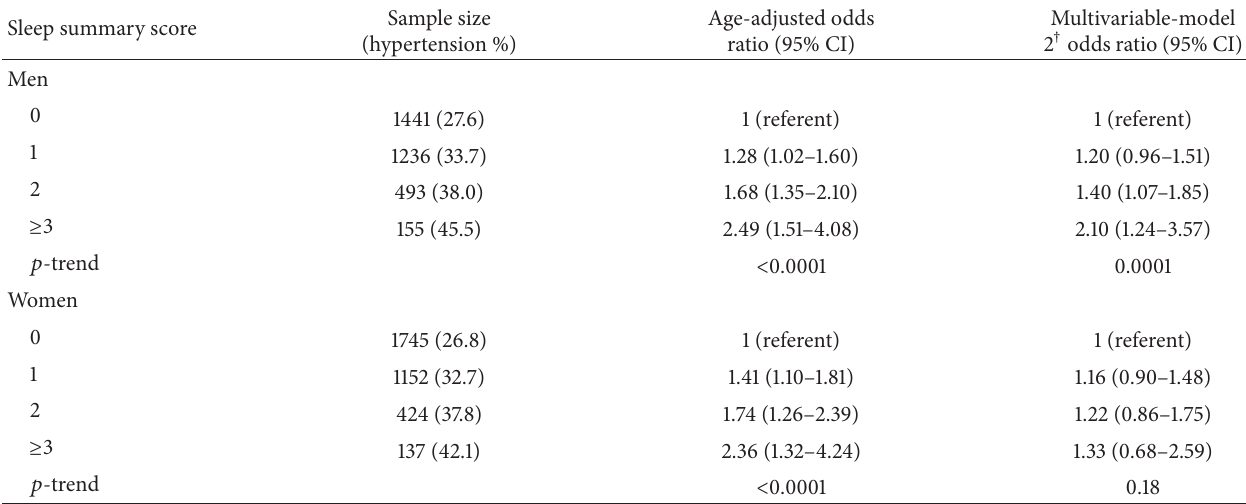
Table 3: Association between sleep variables and hypertension, by gender.